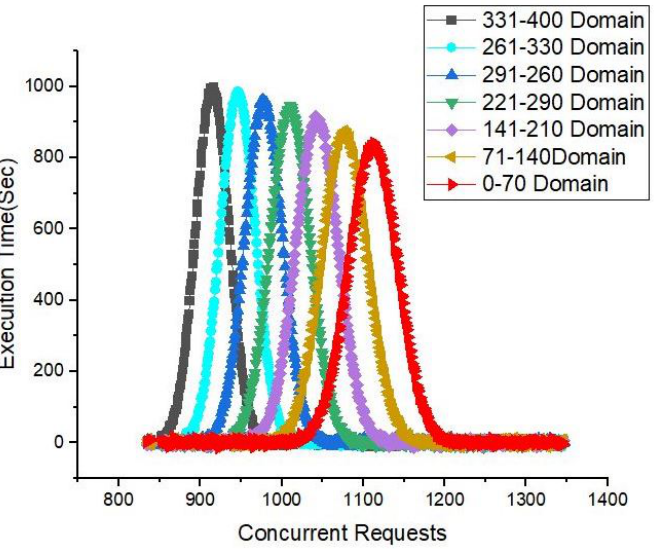
Figure 19. Comparative analysis of the proposed flexible policies for the cross-domain